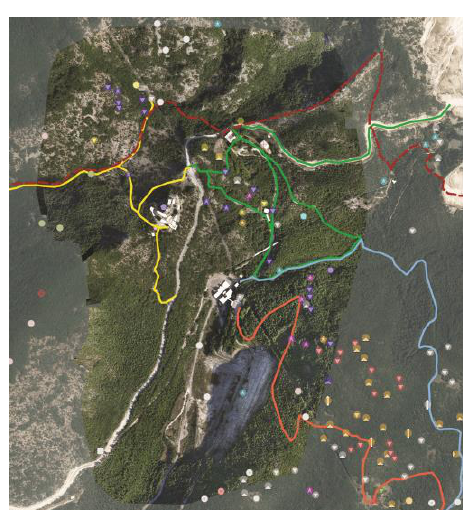
Figure 3. Orthophoto realized by the eBee platform and regional orthophoto of GEOscopio, individuation of the paths and the mining sites in the area.